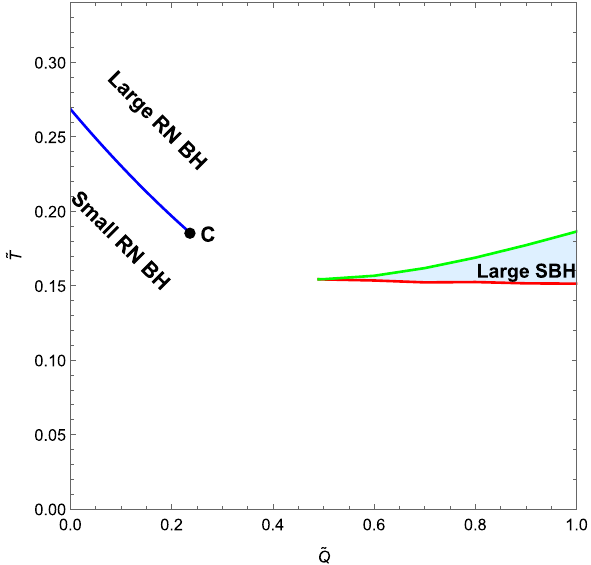
Fig. 4 Phase diagrams of RN black holes and scalarized black holes enclosed by a cavity in the ˜ Q - ˜ T plane with α = 10. The phase diagram exhibits the globally stable phases, which have the lowest free energy. The first-order phase transition line separating Large BH and Small BH is displayed by blue lines and terminate at the critical point, marked by black dots C . In the blue region, the Large scalarized BH (Large SBH) is globally stable. It shown that a reentrant phase transition hap- pens when ˜ Q is large enough. This reentrant phase transition consists of a zero-order phase transition and a second-order phase transition, corresponding the red line and green line,